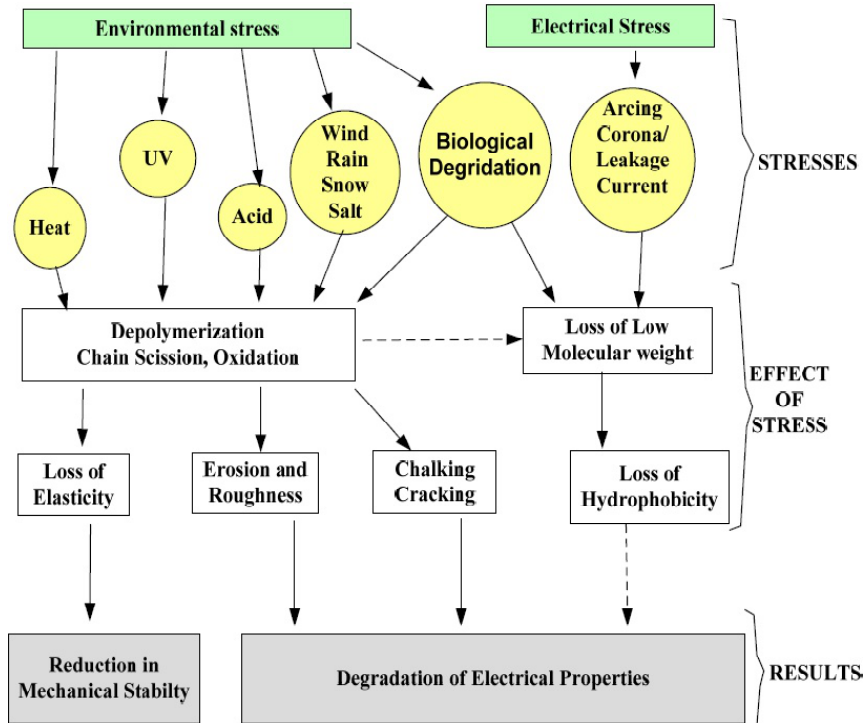
Fig. 16. Factors involved in aging of a polymeric